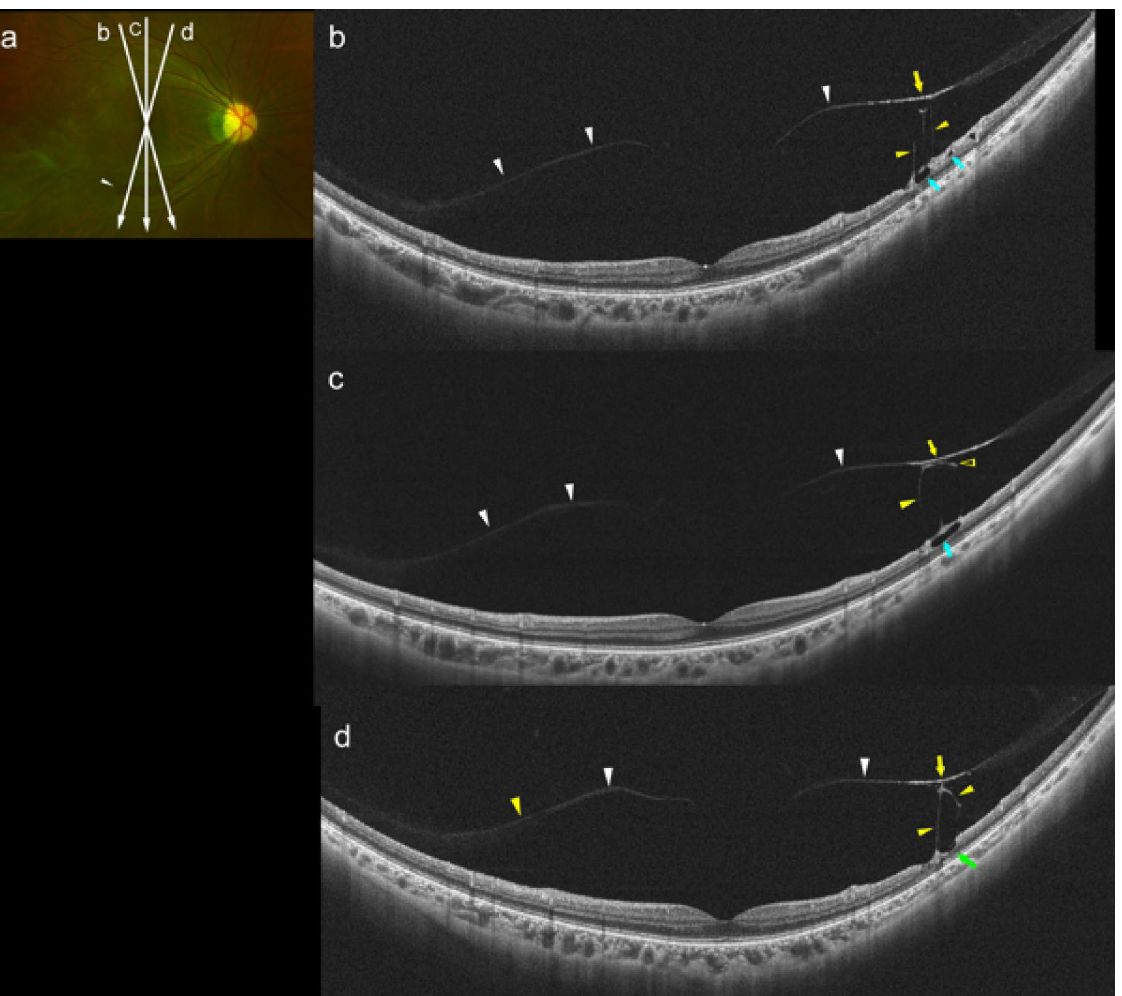
Figure 5. Findings in a 27-year-old woman with high myopia (HM) showing vitreous cortex splitting and bridging tissue between the detached vitreous and retinal vessels. ( a ) Fundus photograph of the right eye with a refractive error of − 8.4 diopters and axial length of 26.23 mm. Arrows show the lines scanned by the ultra-widefield (UWF) OCT device. Inner retinal hemorrhage is seen around the retinal vein inferior to the macular area (white arrow). ( b ) Oblique UWF OCT image showing a partial posterior vitreous detachment (white arrowheads). Part of the posterior vitreous cortex is connected to the inner retinal surface by bridging tissues with higher reflectivity (yellow arrow). Bridging tissues aligned perpendicularly from the inner retinal surface (yellow arrowheads). Paravascular retinal cysts are seen at the site of the adhesions (light blue arrows). ( c ) Vertical UWF OCT image showing posterior vitreous detachment (white arrowheads). Part of the vitreal surface shows adhesions to bridging tissues (yellow arrowheads) and higher reflectivity (yellow arrow). Medium reflective tissue bridges between the posterior vitreal surface with relatively higher reflectivity and inner retinal surface accompanied with retinal cyst (yellow arrows). An operculum-like tissue adheres to the posterior vitreous surface (open yellow arrow) and large paravascular cyst can be seen (light blue arrow). ( d ) Adjacent oblique UWF OCT image showing posterior vitreous detachment (white arrowheads), and a part of the vitreal surface shows adhesions to bridging tissues (yellow arrowheads) and a higher reflectivity (yellow arrow). Paravascular lamellar hole is present at the site of an adhesion (light green